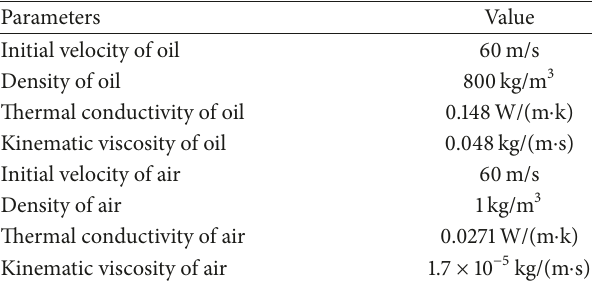
Table 2: Material properties of